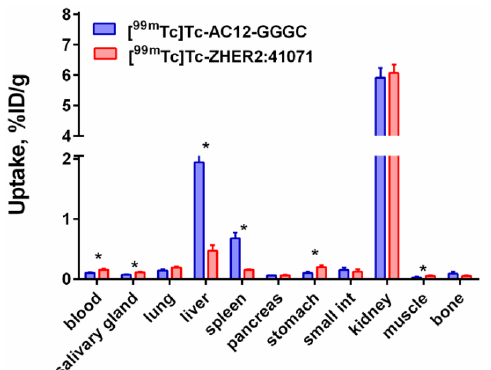
Figure 7. Comparative biodistribution of [ 99m Tc]Tc-AC12-GGGC and [ 99m Tc]Tc-ZHER2:41071 Affibody molecules in different organs and tissues of female NMRI mice at 4 h after injection. 3 µg of labelled Affibody molecule (60 kBq, 100 µL in PBS) was injected into the tail vein. Data are expressed as %ID/g and are averages from four mice ± SD. The significance indicator (*) corresponds to p < 0.05 in.